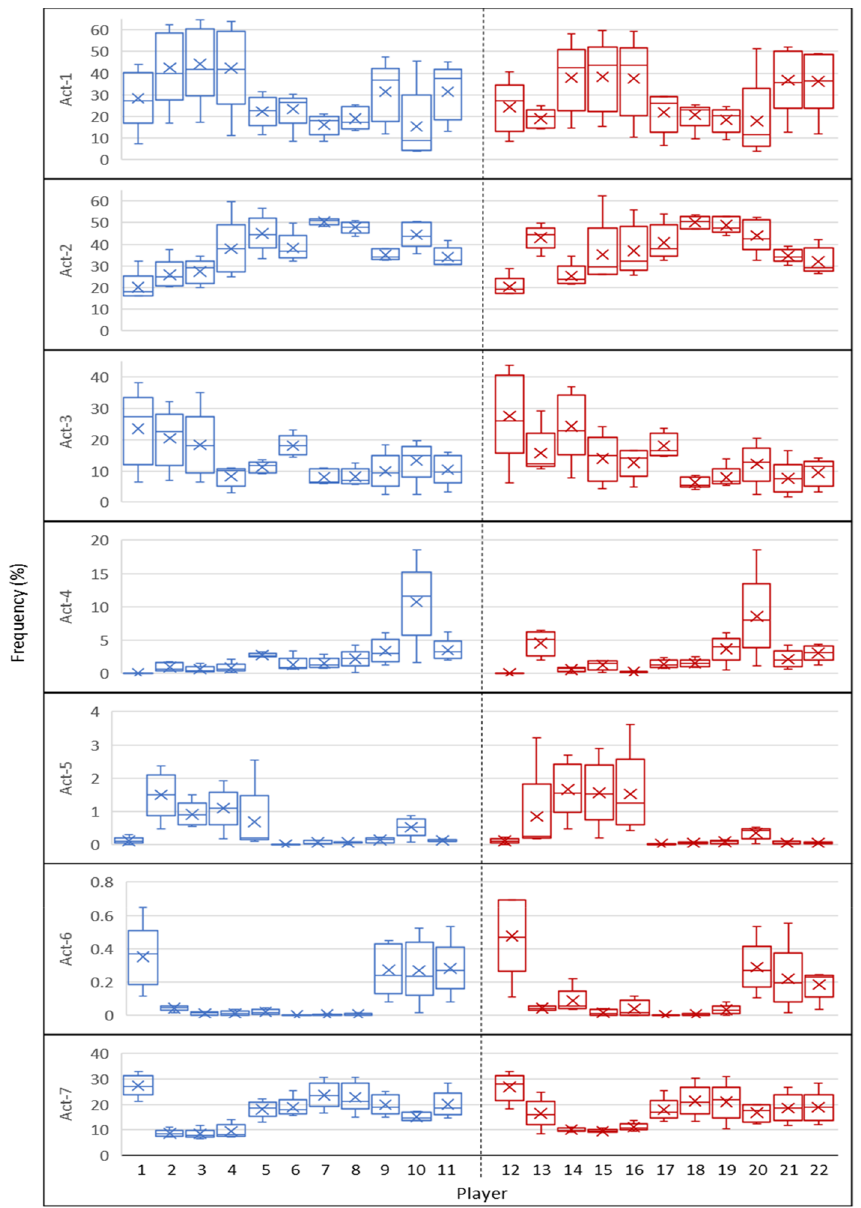
Figure 6. The variation of executed actions over all configurations, at individual-level. Note that the Y axis is represented with different scales due to the various frequency of the executed actions. Act-4 to 6, for example, do not get executed often because they require players to possess the ball. The middle horizontal line and the cross sign, respectively, represent the median and mean of each action across all configurations. Actions are abbreviated as follows: move randomly (Act-1), mark the nearest opponent (Act-2), get possession of the ball (Act-3), carry the ball (Act-4), pass the ball (Act-5), shoot the ball (Act-6), open-up the space